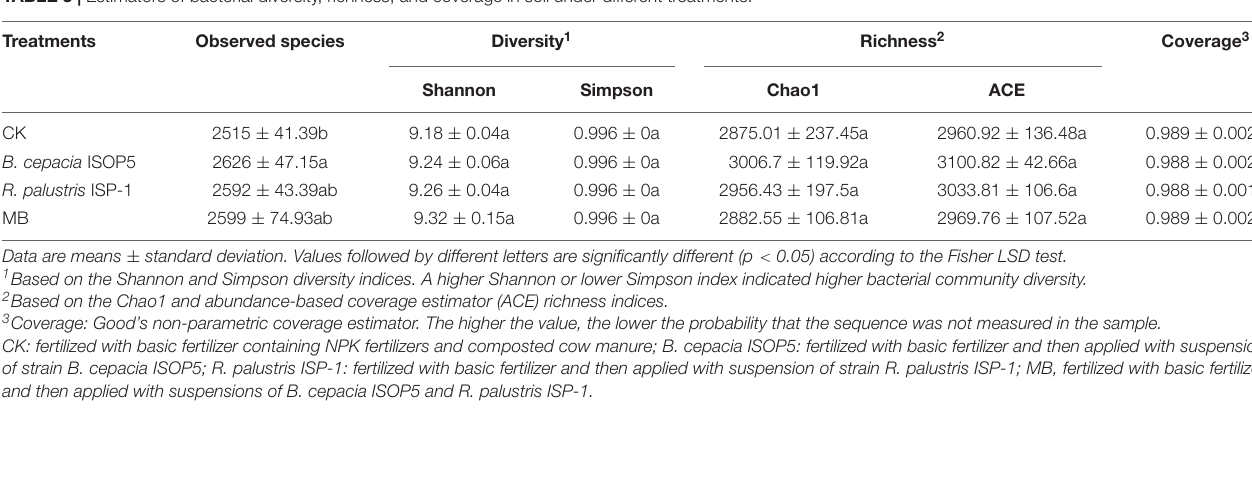
TABLE 3 | Estimators of bacterial diversity, richness, and coverage in soil under different